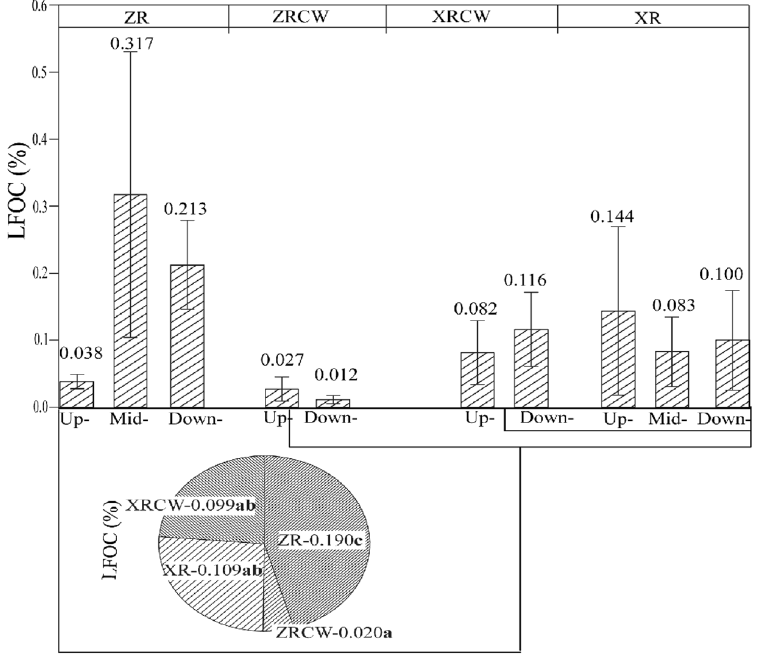
Figure 2. Cluster analysis and distributed difference of LFOC among the four wetlands. Up/Mid/Down-ZR: upstream/midstream/downstream of Zhaoniu River. Up/Down-ZRCW: upstream/downstream of Zhaoniu River Constructed Wetland. Up/Mid/Down-XR: upstream/midstream/downstream of Xinxue River. Up/Down- XRCW: upstream/downstream of Xinxue River Constructed Wetland. Data with the same lowercase letter (a or b) are not significant at α = 0.05 (Duncan